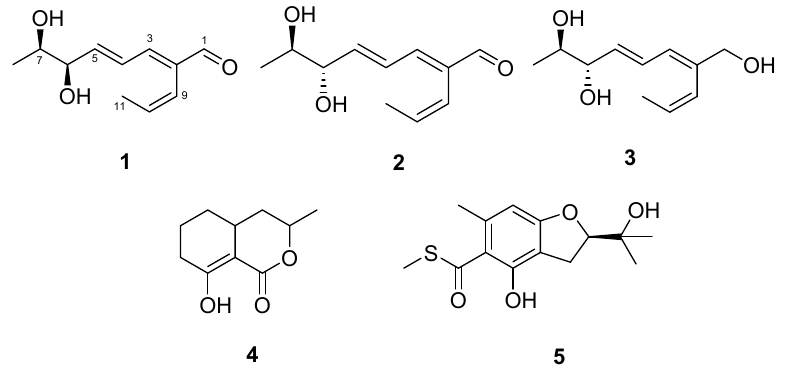
Figure 1. Structures of compounds 1 − 5 isolated from Talaromyces cyanescens .